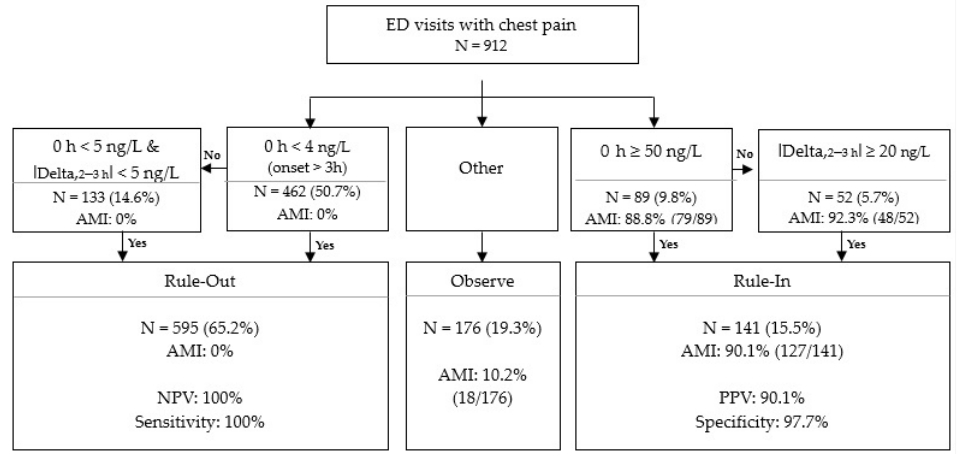
Figure 4. 0/2–3 h algorithmic approach for AMI diagnosis using the baseline Access hs-TnI values at ED presentation and the absolute delta values between the second and baseline hs-TnI.